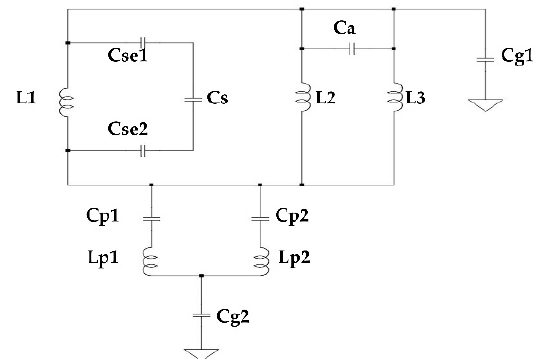
Figure 11. Equivalent circuit of the proposed antenna (Antenna 4 in Figure 7d). Here, Cse1 and Cse2 = The capacitance between the edges of the capacitive gap and the left arm. Cs = The capacitance due to the gap of L6. Ca = The capacitance be-tween the two arms on the right side. Cp1 and Cp2 = The capacitances between the parasitic blocks and the patch.Cg1 and Cg2 = The coupling capaci- tances between the patch and parasitic blocks with the ground.